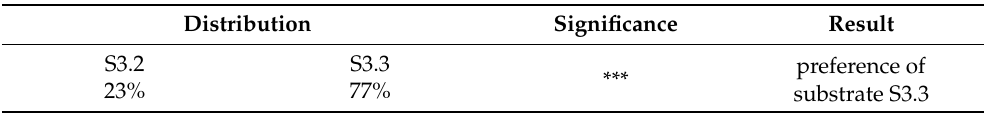
Table 7. Results of the avoidance test with the earthworms Eisenia andrei exposed to a third set of tested substrates for 48